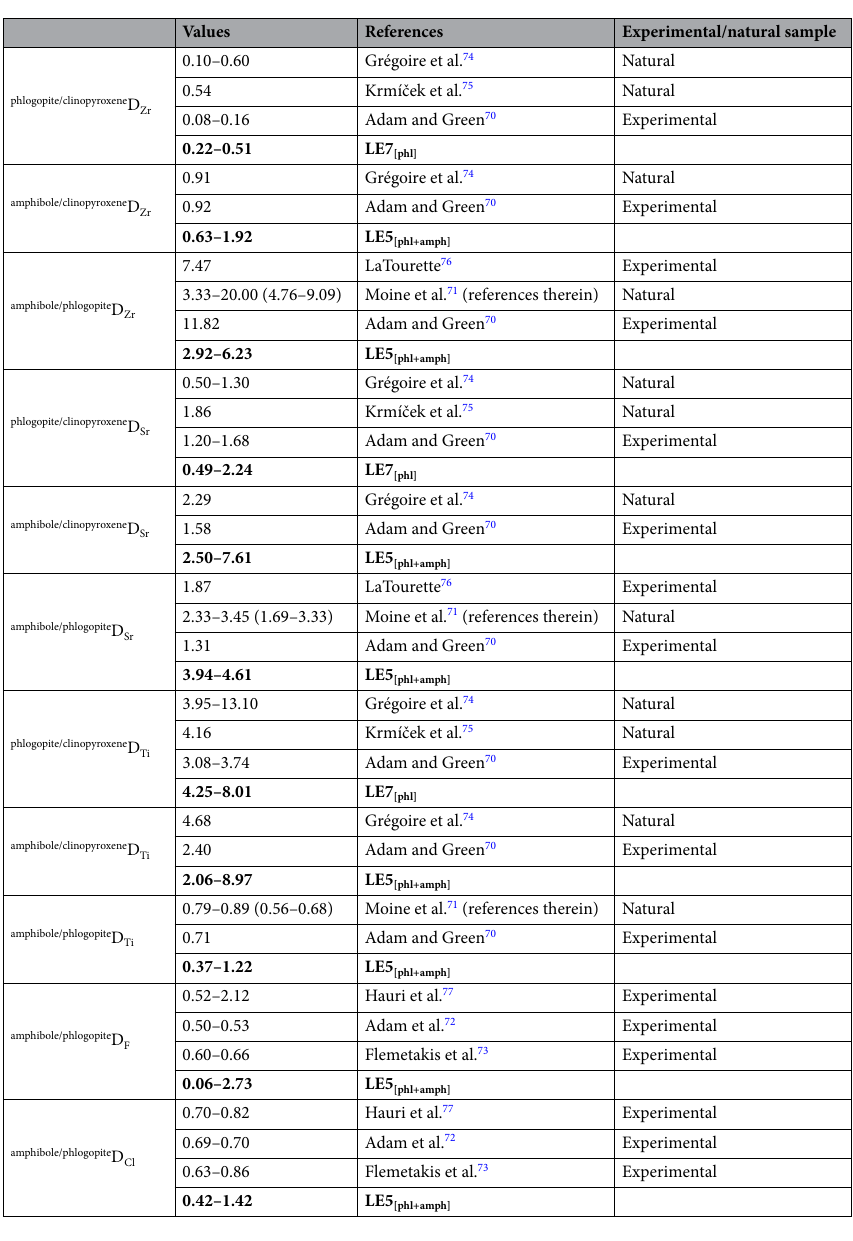
Table 2. Calculated phlogopite/clinopyroxene ( phlogopite/clinopyroxene D), amphibole/clinopyroxene ( amphibole/clinopyroxene D), amphibole/phlogopite ( amphibole/phlogopite D) partition coefficients for Zr, Sr, Ti, F, and Cl of Mount Leura peridotite xenoliths (bolded values), along with values reported in literature where clinopyroxene, phlogopite and amphibole coexist as mineral phases in each experimental run or in natural